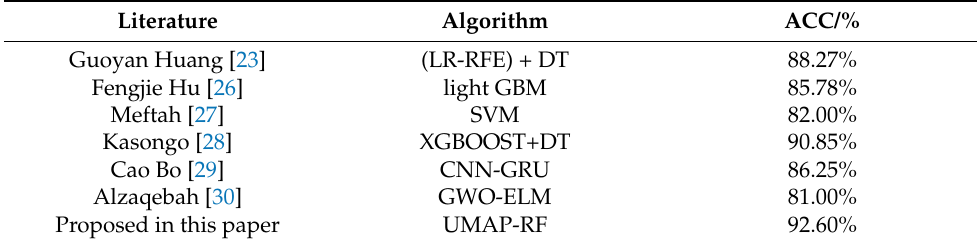
Table 6. Comparison of the detection effect of UMAP-RF hybrid algorithm and other